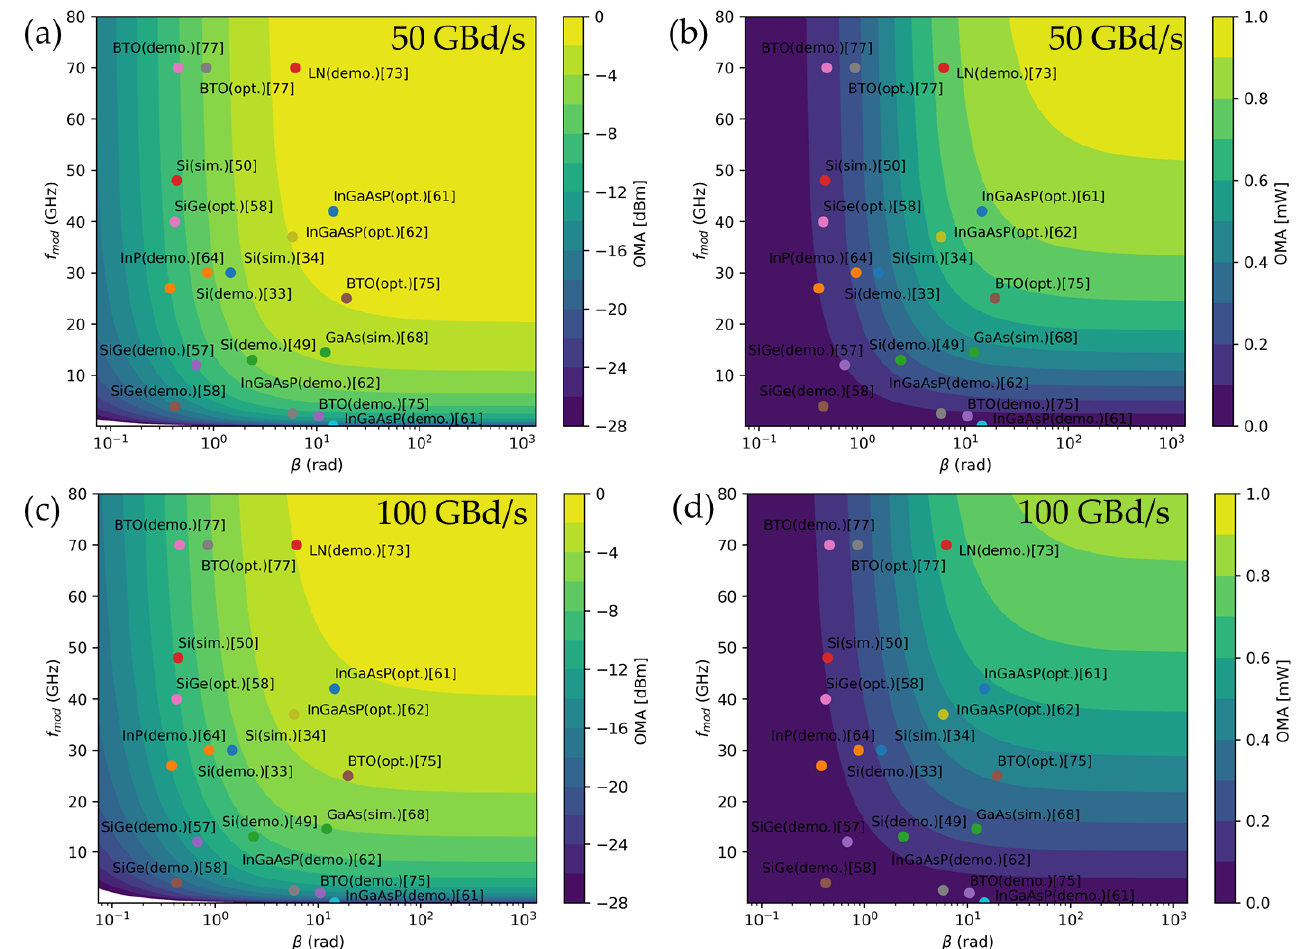
Figure 8. ( a ) Performance comparison of dynamic OMA for variable hybrid and Si optical phase shifters at the data rate of 50 GBd/s in ( a ) mW and ( b ) dBm scale, and 100 GBd/s in ( c ) mW and ( d ) dBm scale.